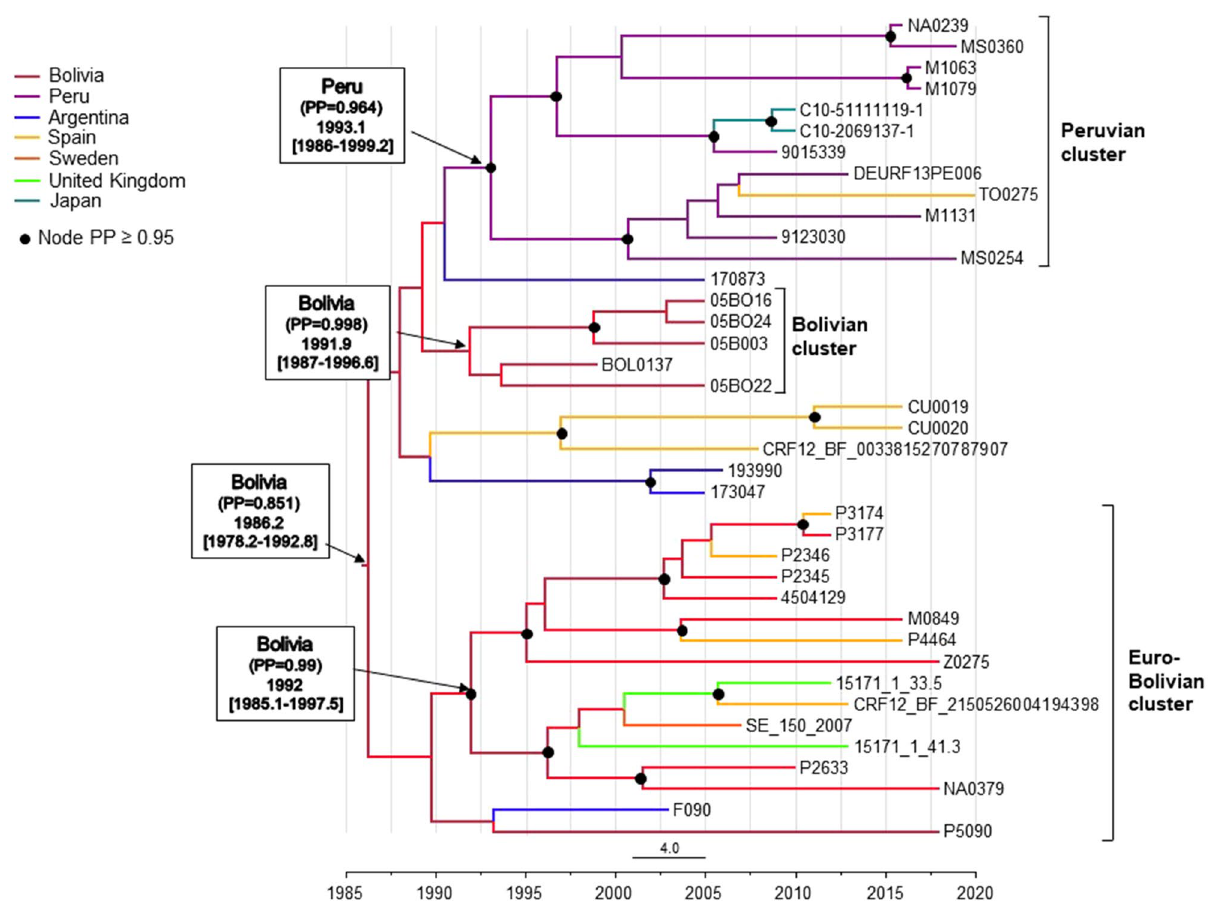
Figure 6. Maximum clade credibility tree of CRF89_BF Pr-RT sequences. Branch colors indicate, for terminal branches, country of sample collection or, if known, of origin of the individual, and for internal branches, the most probable location country of the subtending node, according to the legend on the left. Nodes supported by PP ≥ 0.95 are indicated with filled circles. Most probable countries at the root of the tree and of the three major clusters are indicated, together with PP supporting the locations and tMRCA (mean values, with 95% HPD intervals in